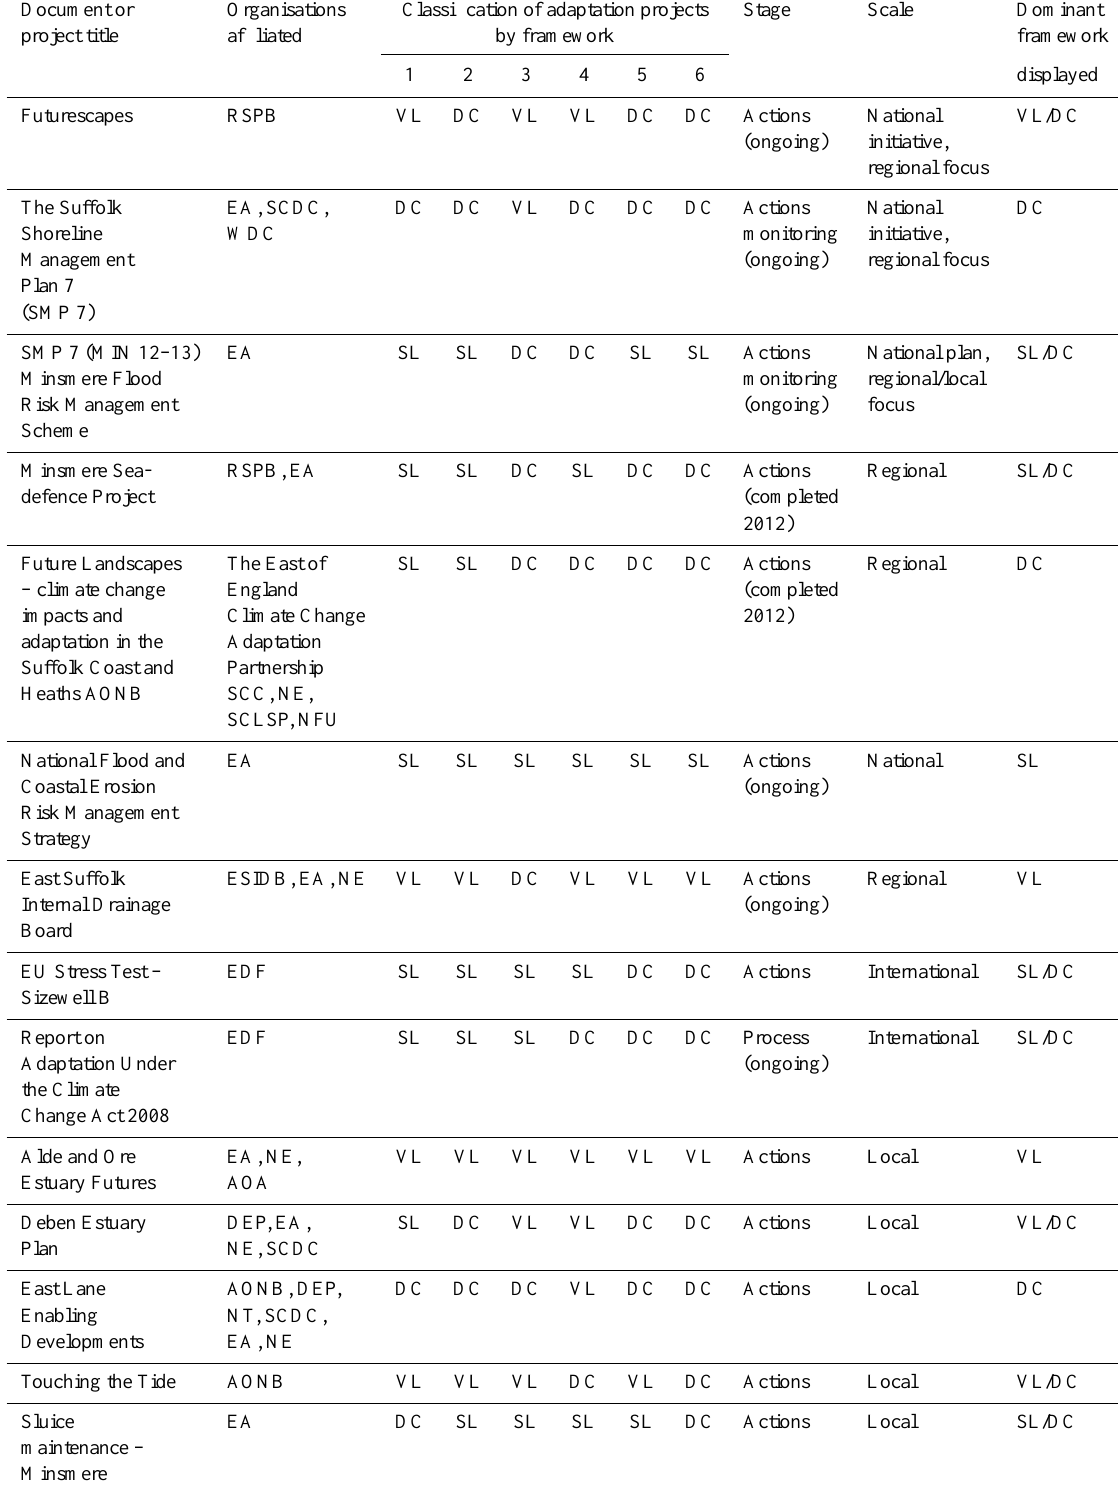
Table A2. The dominant framework takes a single framework if five hallmarks are in the same framework and hybrid frameworks where at least two hallmarks are in the same